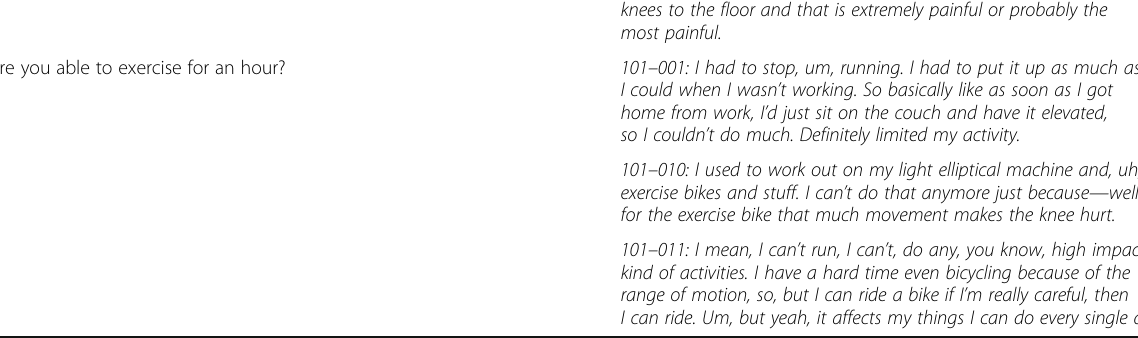
knees to the floor and that is extremely painful or probably the most painful.